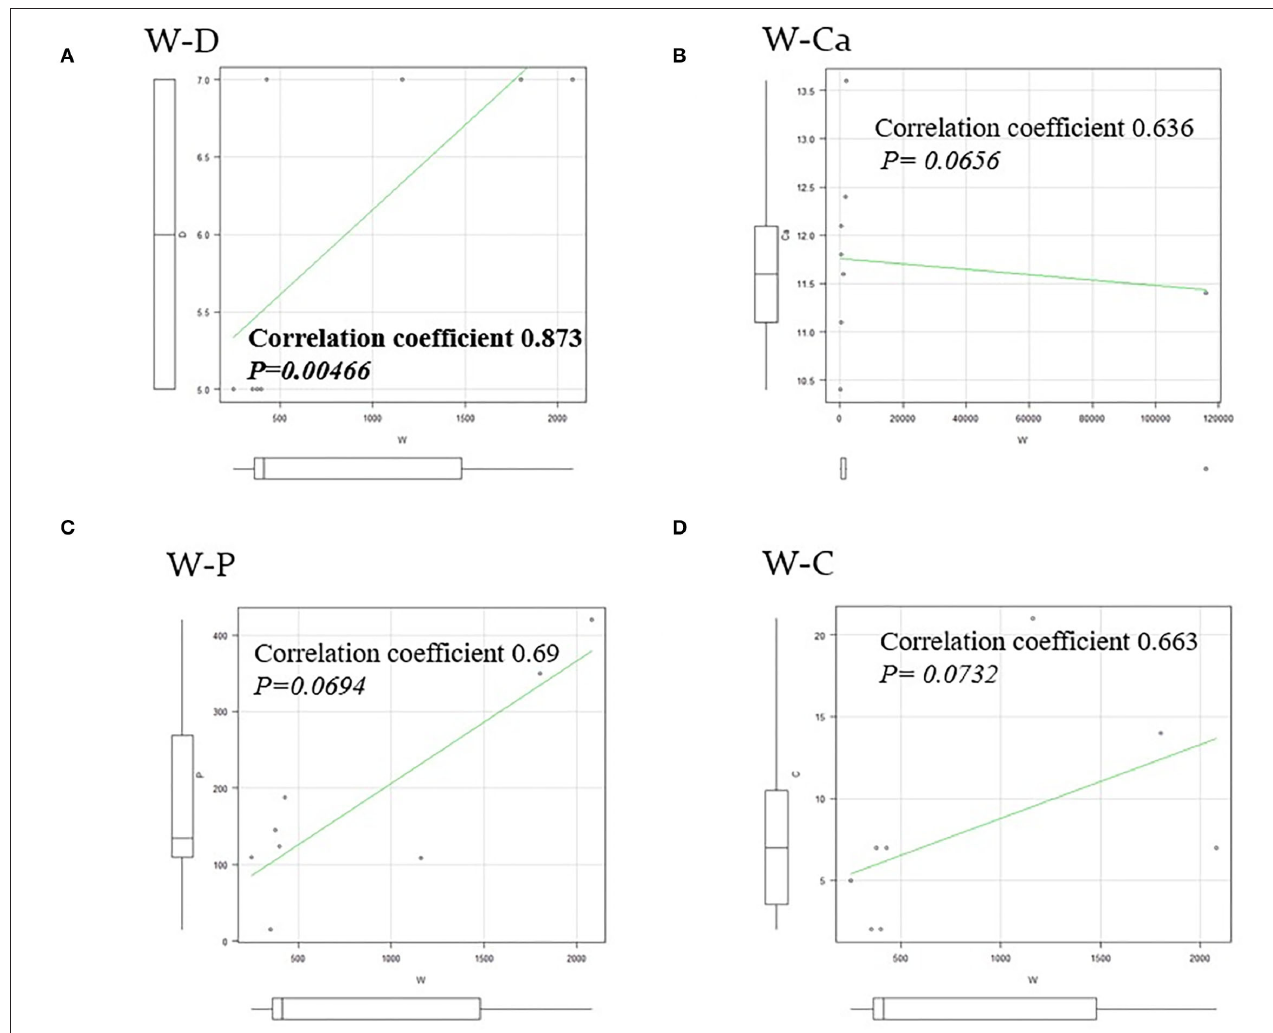
FIGURE 8 | A rank correlation coefficient and differences. (A) There was a strong correlation between the weight of specimens and the length of hospital stay (W–D), with a rank correlation coefficient of 0.873, and differences at a p = 0.00466 were considered significant. (B–D) There was no correlation between the weight of specimens and the preoperative corrected Ca (W–Ca), the preoperative i-PTH (W–P), and the postoperative hypocalcemia course for normalized period